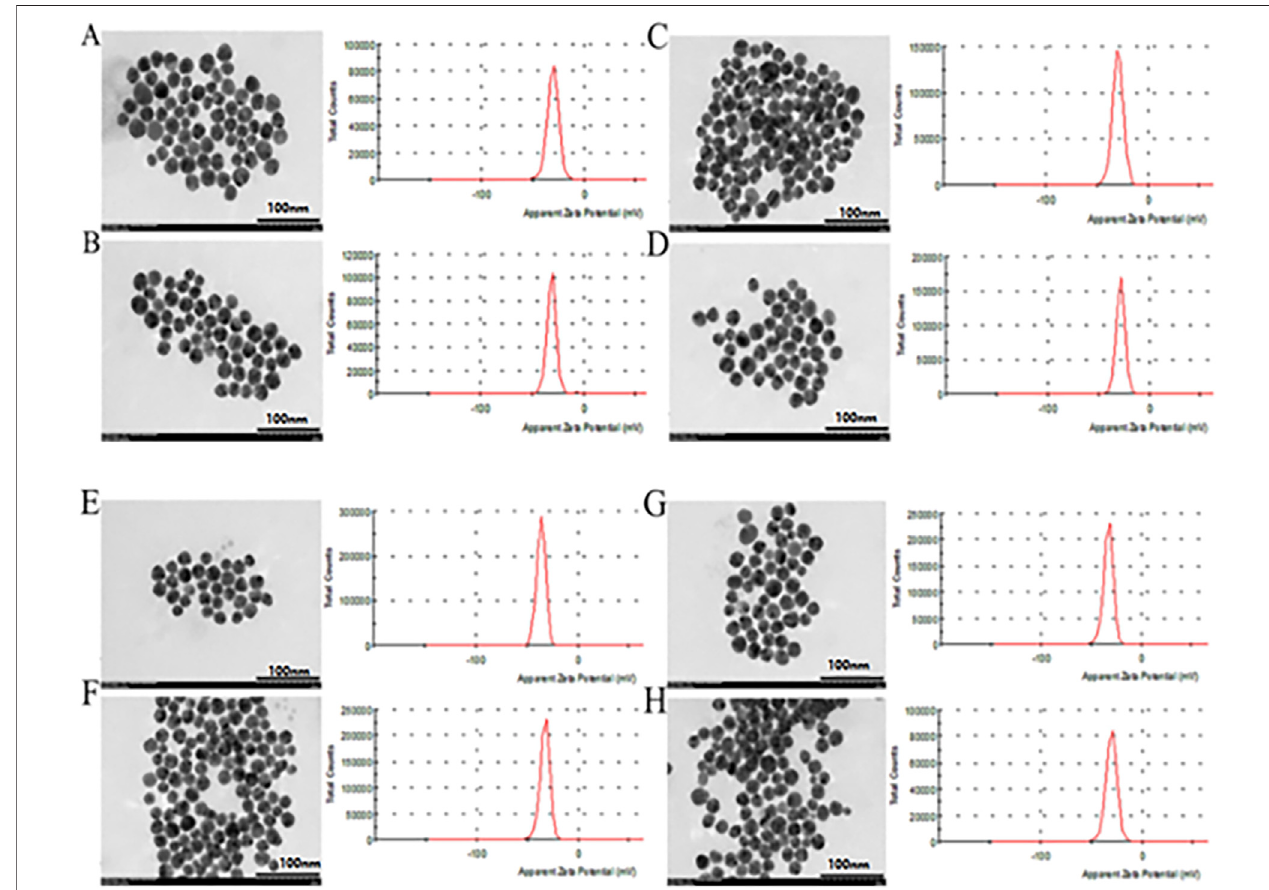
FIGURE 2 | The particle size distribution, TEM and zeta potential of colloidal gold prepared by reduction with Cc (A) , Hq (B) , Rs (C) , Vc (D) , Ga (E) , Sc (F) , Sm (G) and St (H) .